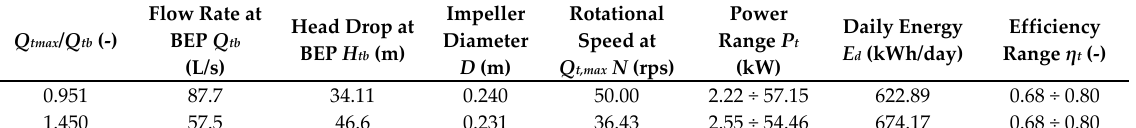
Table 2. PAT design parameters as a function of Q t,max / Q tb ratio—Scenario 2. Q tmax / Q tb (-)